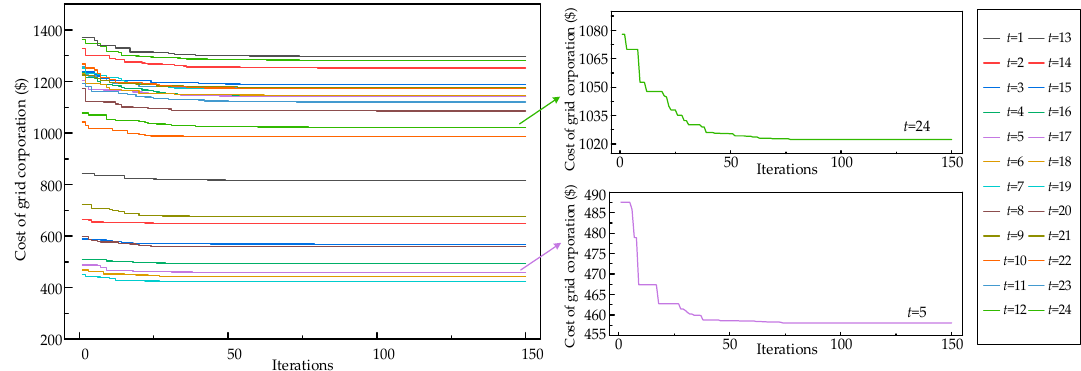
Figure 5. Optimal individualized incentive prices and corresponding volume of load shedding over a 24-h period for users 1, 2, 11 and 13.